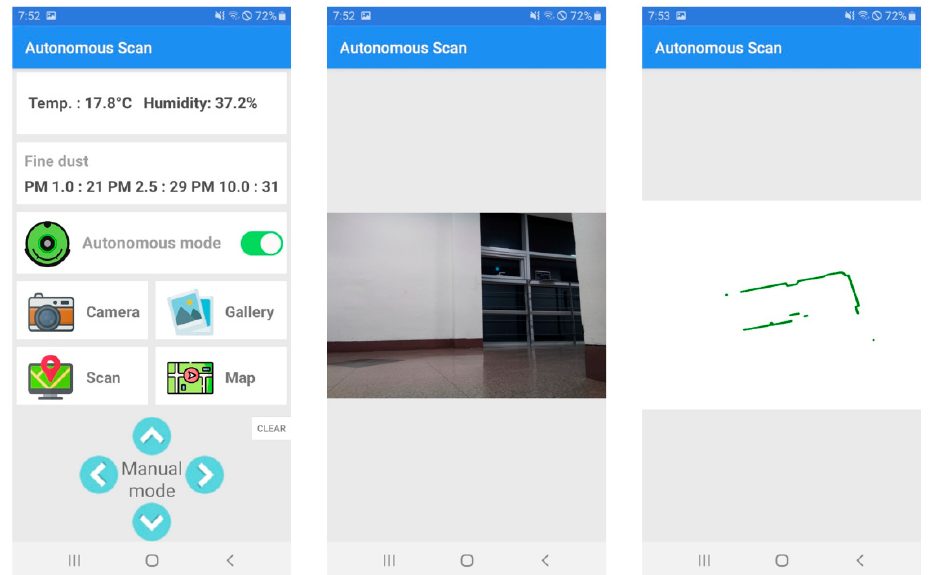
Figure 19. Environmental data result ( left ), captured image ( middle ), and scanned result ( right ) at position (marked 4 in Figure 15) from which first autonomous scanning experiment was performed.